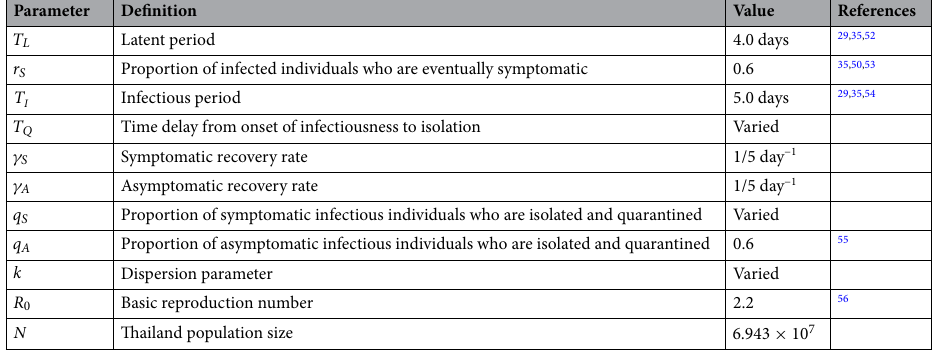
Table 1. Descriptions and values of all parameters used in the